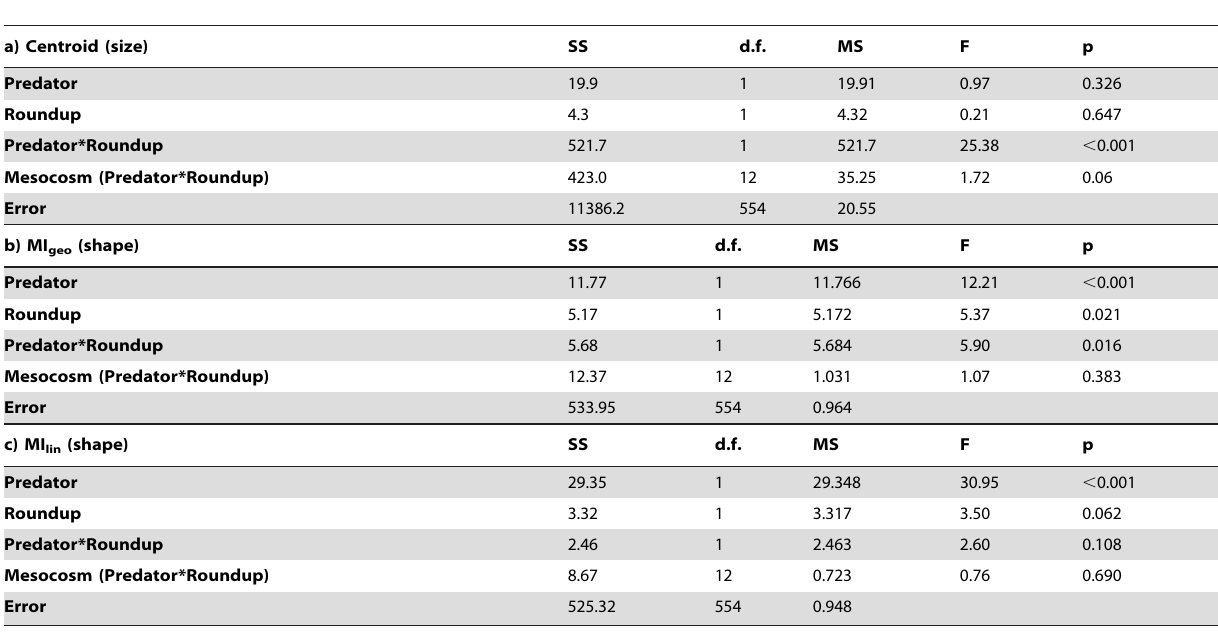
Table 6. ANOVAs to determine if predator cues and Roundup (including their interaction) influenced size (a; centroid), or shape (b and c) of tadpoles (MI geo , for geometric morphometric measurements, or MI lin, for linear measurements, respectively) with mesocosm nested within the interaction of predator cues and Roundup (i.e. mesocosm nested within treatment).